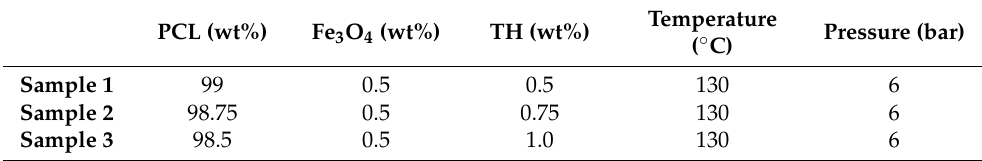
Table 1. Sample contents and their printing